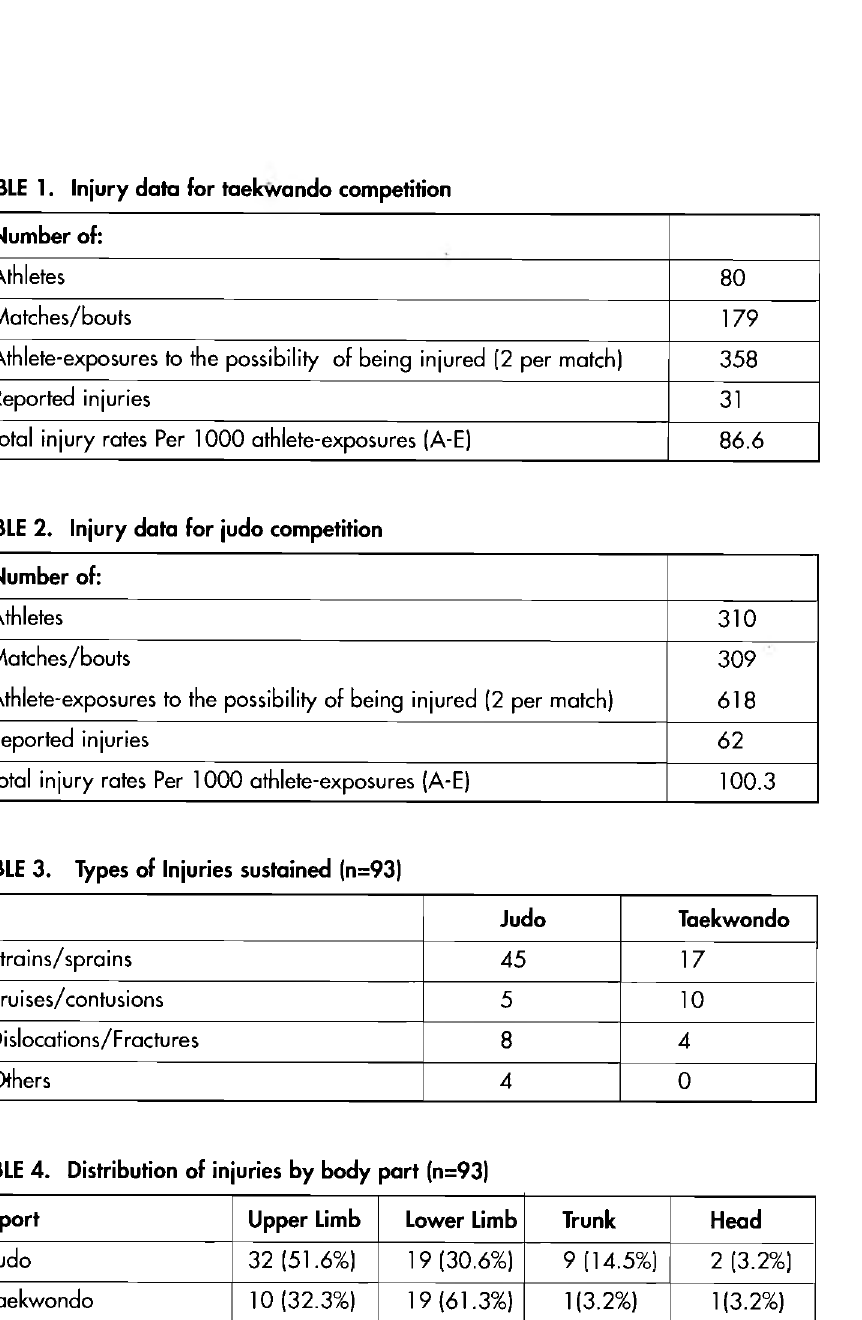
TABLE 4. Distribution of injuries by body part (n=93)